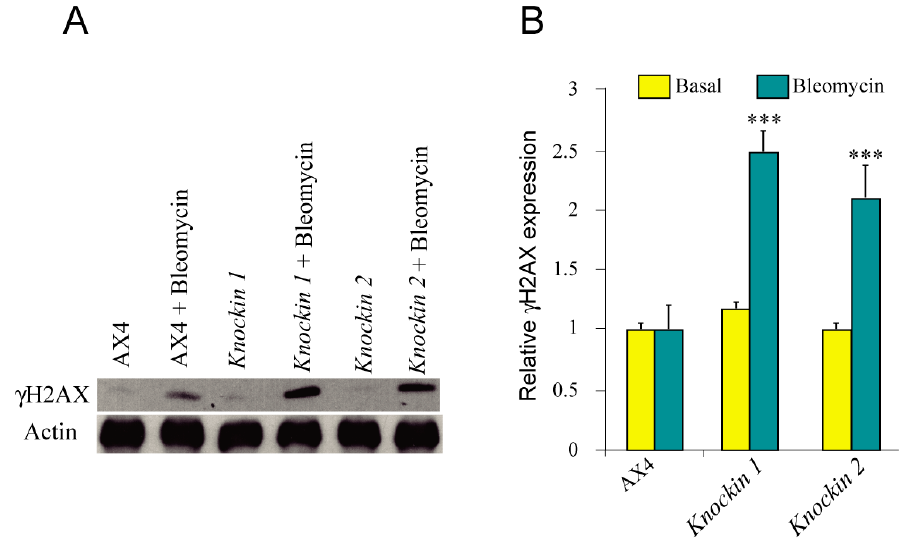
Figure 7. DNA damage response in D. discoideum dyskerin mutants. Wild-type (AX4) and dyskerin-mutant (knockin 1, knockin 2) strains were incubated with bleomycin (+bleomycin) for 3 h, or not, and protein extracts were prepared. ( A ) Panel A shows in the upper blot a representative Western blot obtained after incubation with an antibody specific for phosphorylated histone H2AX ( γ H2AX). The blot was washed and incubated with an anti-Actin antibody as a loading control (lower blot). ( B ) Panel B shows the quantification of the blots from three independent experiments. Samples non-treated with bleomycin are represented in yellow bars, while those obtained from cells treated with bleomycin are represented by blue bars. Mean values and standard deviations are represented. The relative expression obtained for the knockin strains treated with bleomycin was compared to that of treated AX4 cells. *** p < 0.001.